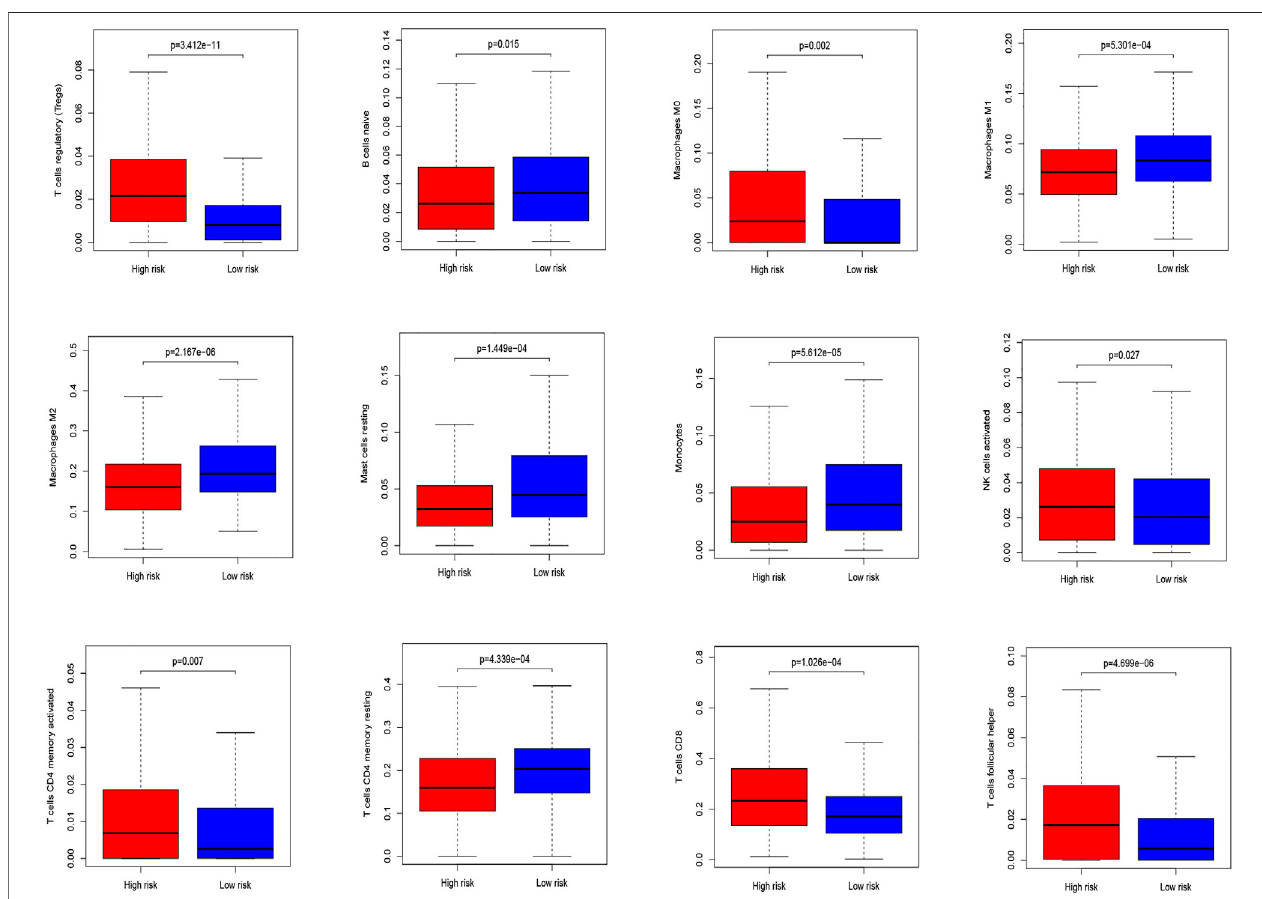
FIGURE 8 | Differential analysis of immune cells in two low-risk